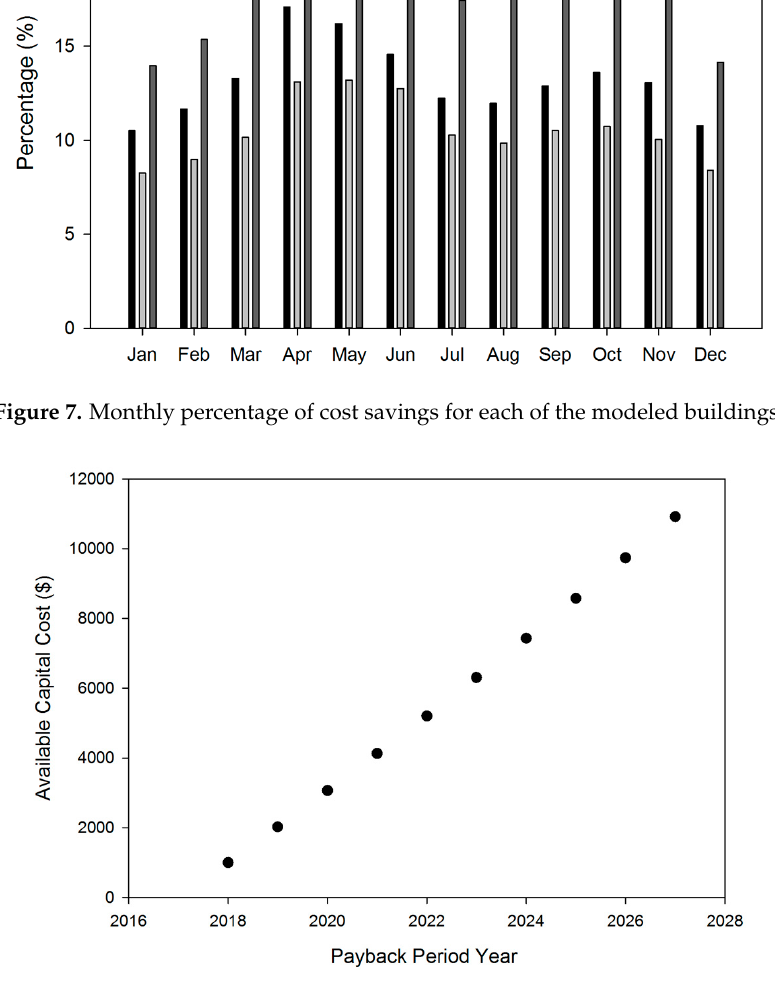
Figure 8. The available capital costs (ACC) for a small office in Tucson, AZ.